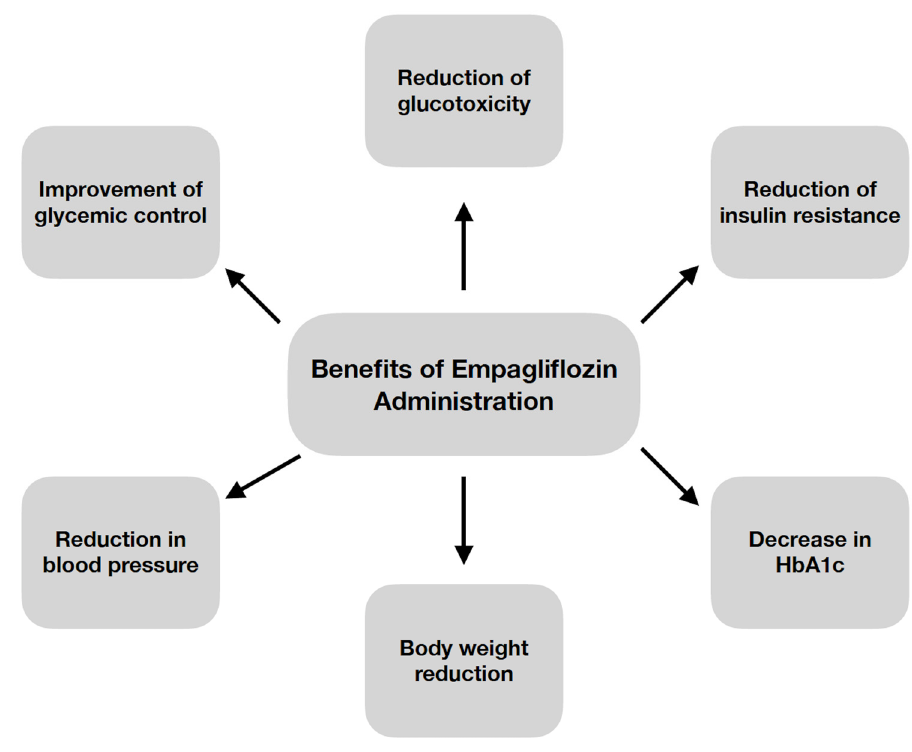
Figure 1. Beneficial effects of empagliflozin administration [2–4,6,7]. HbA1c, glycated hemoglobin